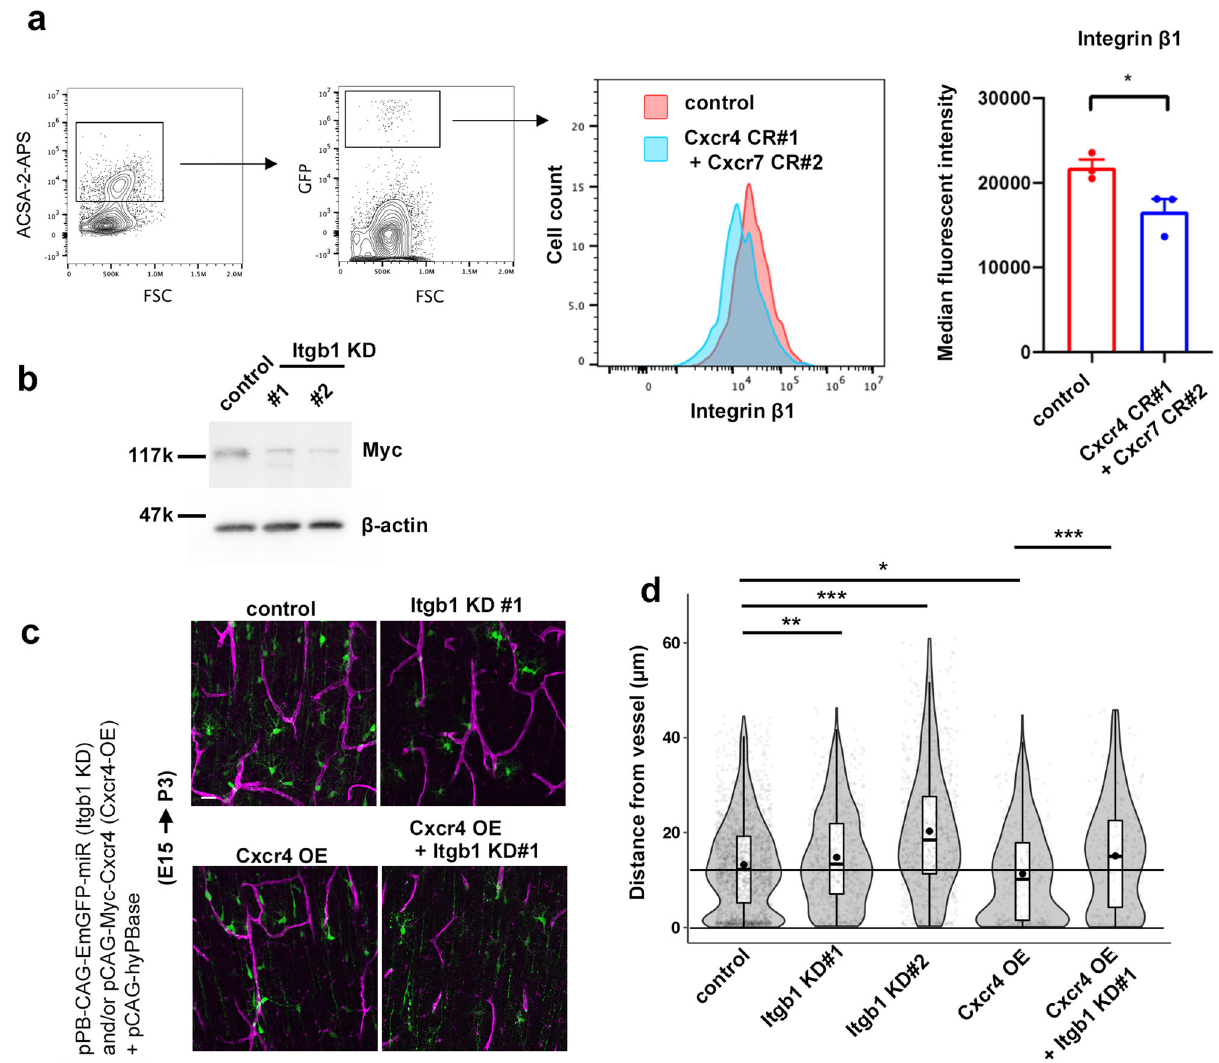
Fig. 7 | Integrin β 1 is involved in Cxcr4-mediated blood vessel-guided migra- tion. a Simultaneous introductionofCxcr4and Cxcr7 CRISPR vectorsreduced the amount of Integrin β 1 on astrocyte progenitors (3 brains/group, two-sided unpaired Student ’ s t test, P =0.0383, the data in the right panel are shown as mean±SEM). CRISPR vectors were electroporated at E15, and the amount of Integrin β 1 on the GFPand ACSA-2 double positive population atP3 wasexamined using a fl ow cytometer. The left dot plot shows the fl uorescence intensity of the ACSA-2 (y-axis) versus the intensity of forward scatter (FSC; x-axis). The right dot plot shows the fl uorescence intensity of the GFP (transfected cells, y-axis) versus the intensity of forward scatter (FSC; x-axis). Histogram shows the number of events (cells) counted (y-axis) versus the fl uorescence intensity of integrin β 1 (x- axis) (red, ACSA-2 + , GFP + cells electroporated with a control vector; blue, ACSA-2 + , GFP + cells co-electroporated with Cxcr4 CR#1 and Cxcr7 CR#2). b Knockdown